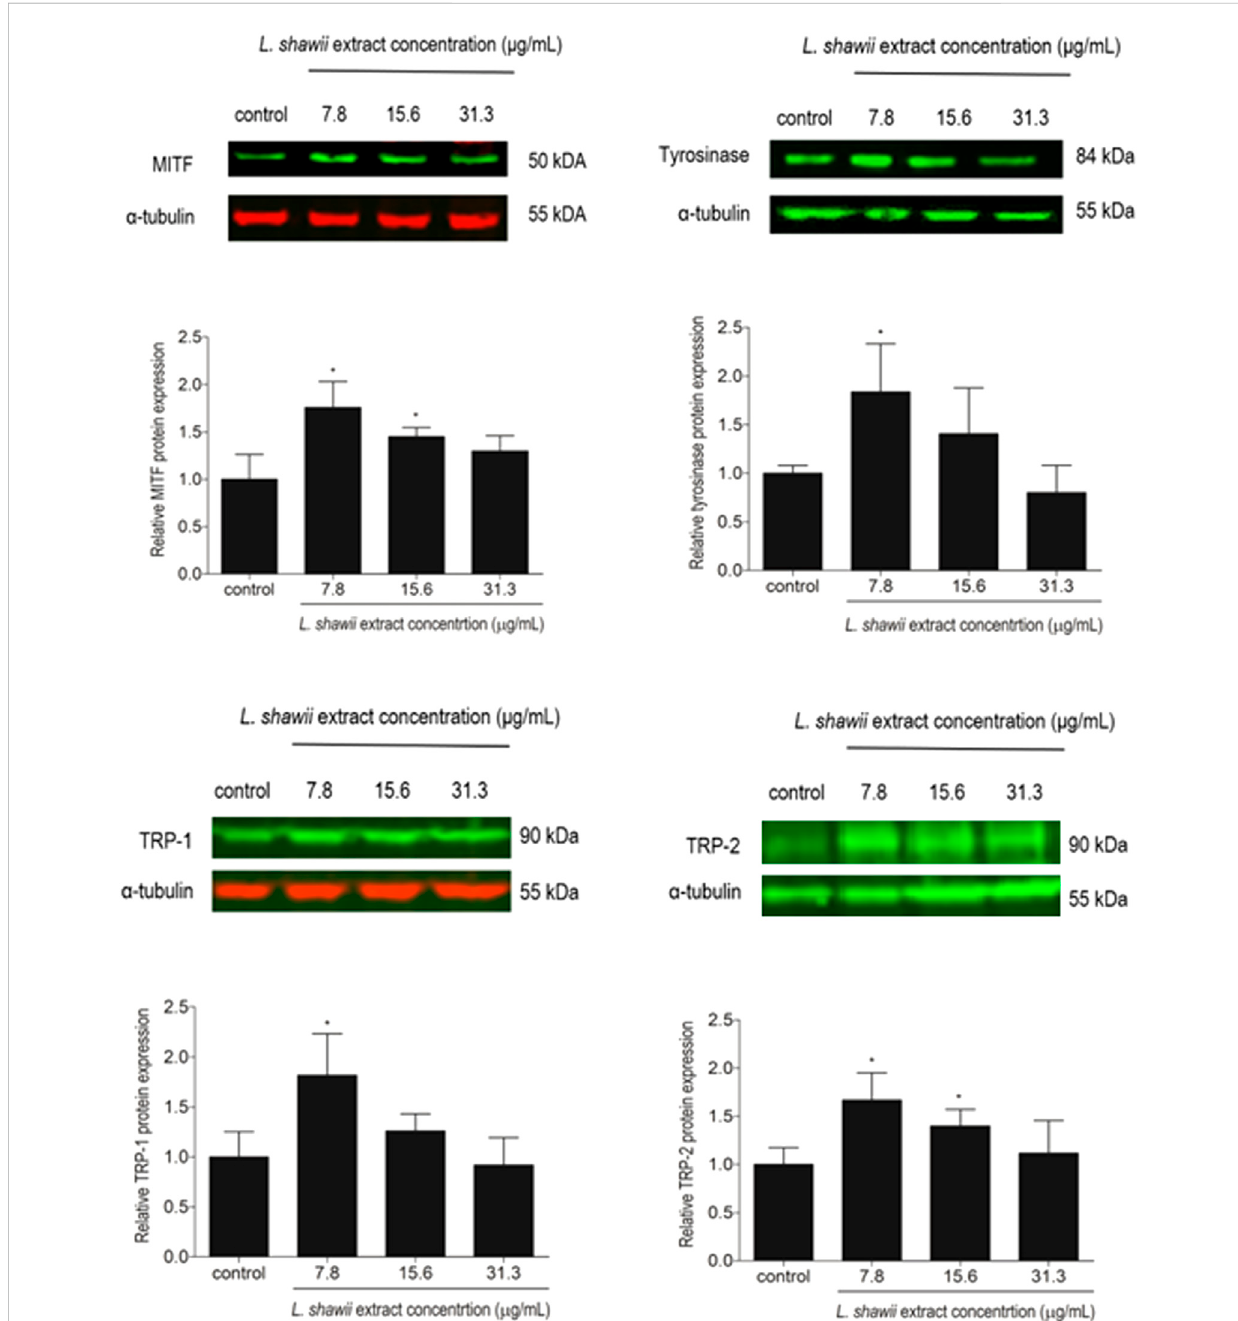
FIGURE 5 Modulatory effects of the L. shawii extract on the protein expression levels of MITF, tyrosinase, TRP-1, and TRP-2 melanogenesis-related proteins using Western blot analysis. Representative Western blots showing the variation of melanogenesis-related protein expression levels in melanocytes after exposuretovariousconcentrations(7.8 – 31.3 μ g/mL)ofthe L.shawii extract.Thebargraphsshowtherelativeexpressionofeachmelanogenesis-related protein calculated as the ratio to the housekeeping protein α -tubulin, compared to the untreated cells. The results are presented as mean ± SD of three independent experiments. * p < 0.05 signify a statistically signi fi cant difference compared with the